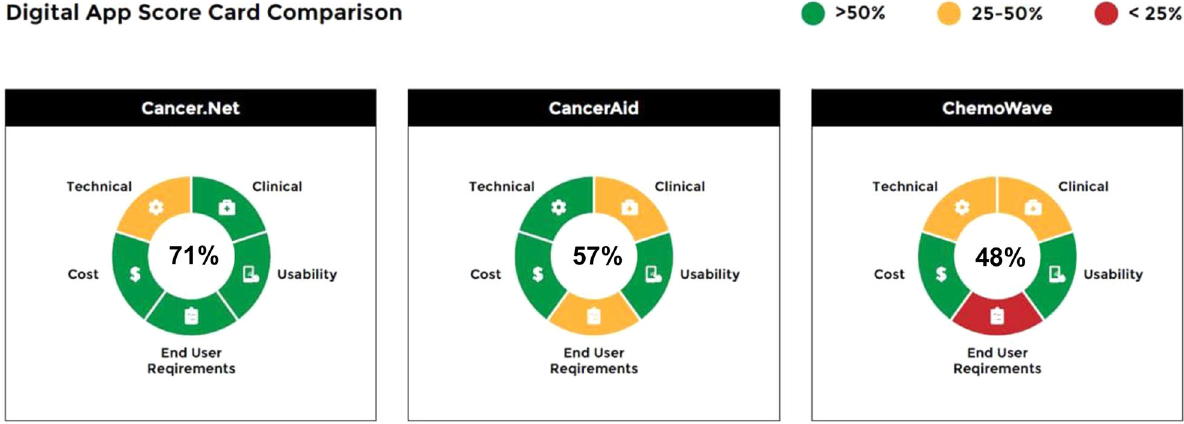
Fig. 6 Digital health scorecard, comparison view. A digital health scorecard comparison for three apps is depicted, with individual domains represented in segmented wheels, and color coded based on performance